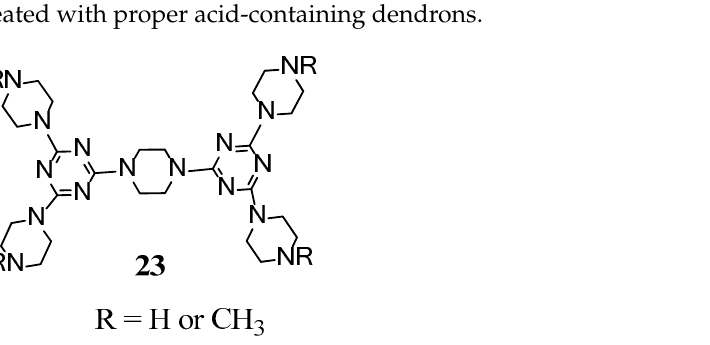
Figure 13. Structure of molecule ( 23 ).